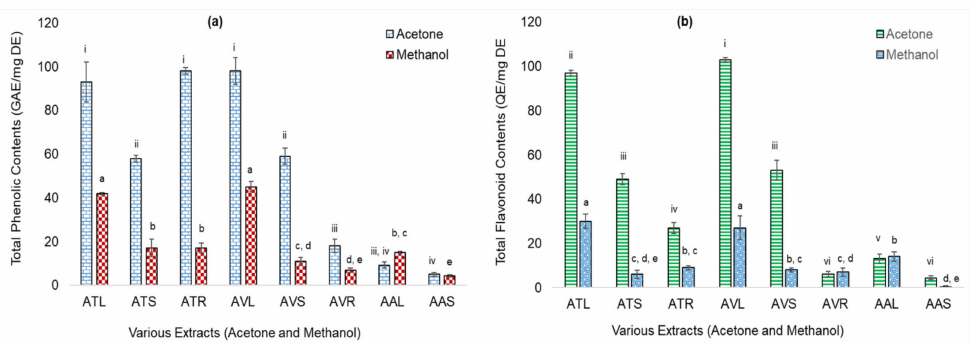
Figure 1. Total Phenolic Contents (TPC) (as microgram Gallic acid equivalents/milligram dry extracts: µ g GAE/mg DE) and Total flavonoid contents (TFC) (as µ g Quercetin equivalents/mg DE: µ g QE/mg DE) of acetone and methanolic extracts of Achyranthes aspera L. (AA), Amaranthus viridis L. (AV), and Amaranthus tricolor L. (AT) plants parts. ( a ) TPC of extracts; ( b ) TFC extracts where, ATL = AT leaves; ATS = AT stems; ATR = AT roots; AVL = AV leaves; AVS = AV stems; AVR = AV roots; AAL = AA leaves; and AAS = AA stems. Values are significant at p ≤ 0.01 and ≤ 0.05 (Different alphabets and roman numerals on the bars, show statistical difference in values within the same